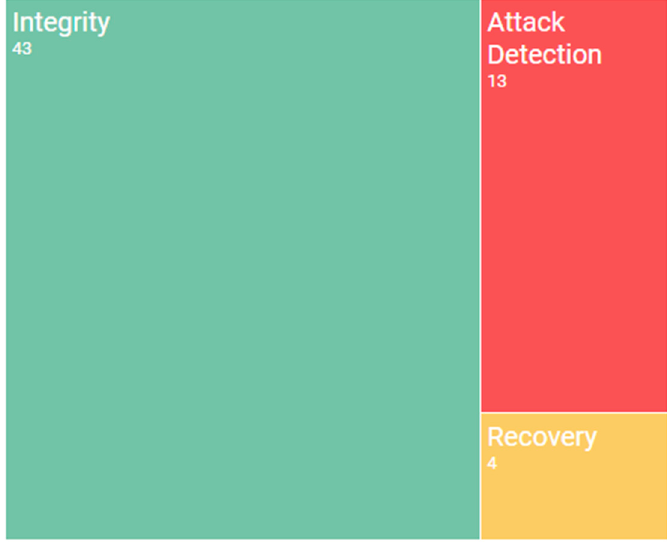
Figure 6. Main topics as regards integrity and reactive security.